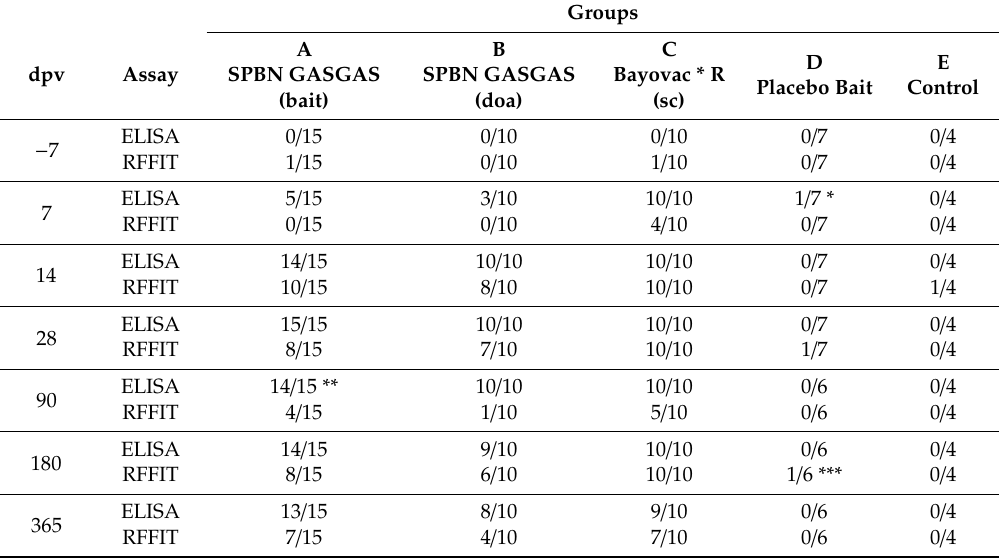
Table 1. Seroconversion rates post-vaccination based on both ELISA and RFFIT results. Groups